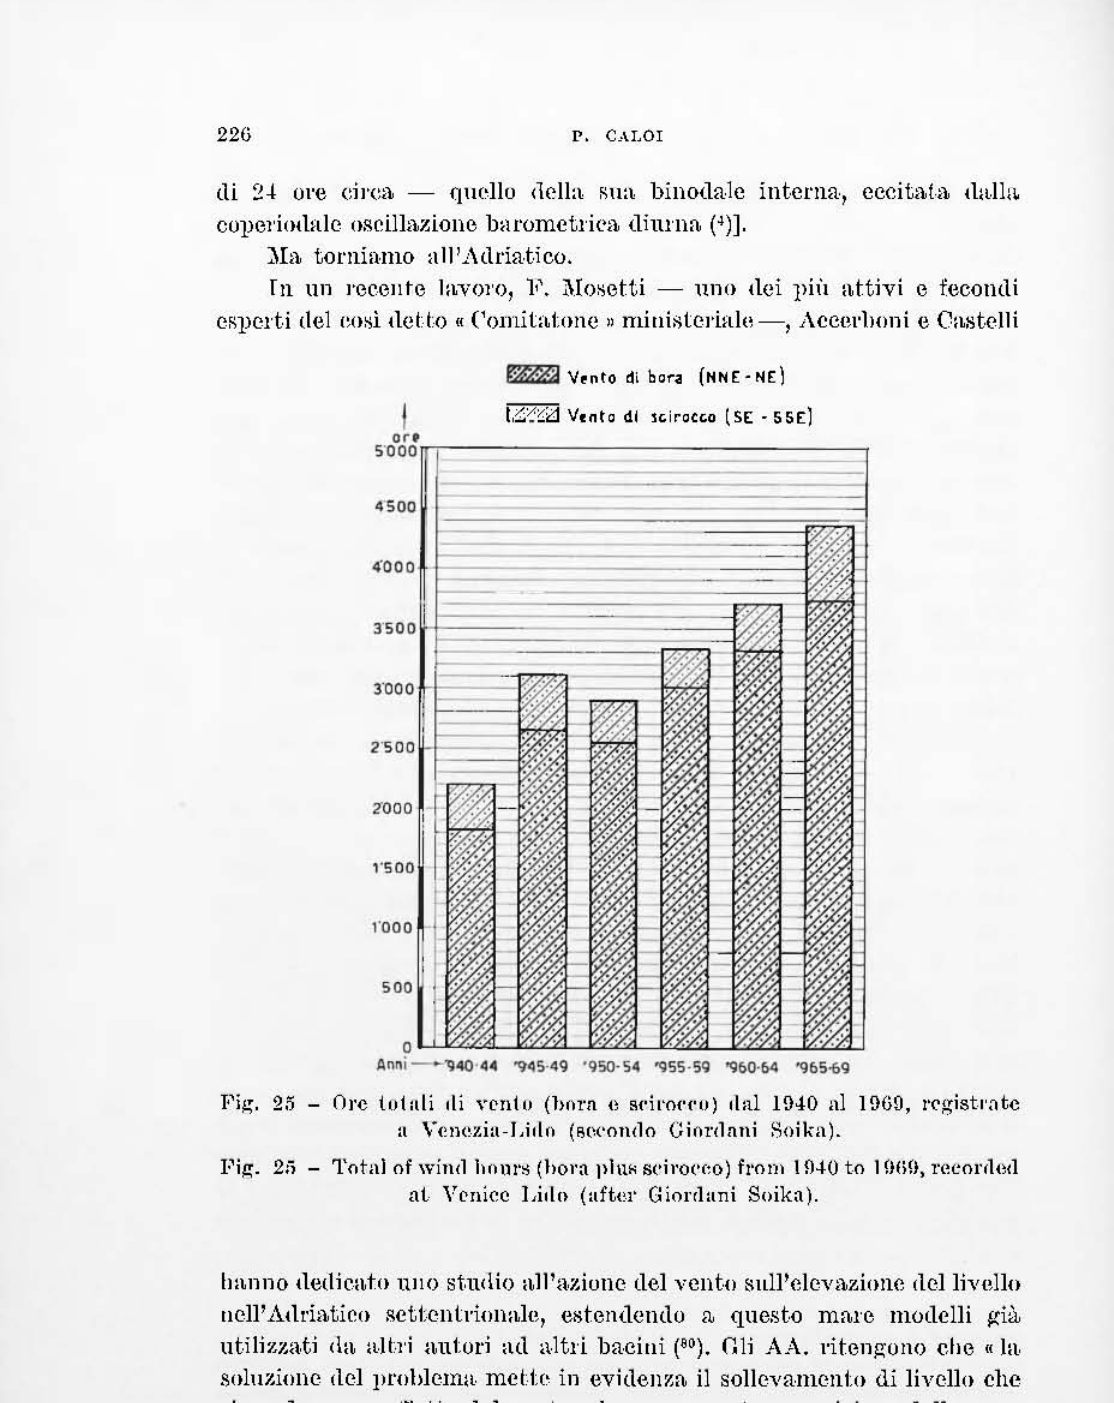
Fig-. 2.'i - Ore totali Ili YC'llto (hora Il sl'il"Ol'I'o) Ilal Hl40 al HI6\), rC'gistl':1tc a V('n('zia-Lillo (8(\('01\(10 Gionlnni :'\oika). Pi,(!;. 2;; - Total of w11\(1 hOl1r~ (hor:1 pluH s('iro('eo) from l D..J.O to l (WO, reeonllll} aL VC'nice Lillo (aftm' Giordani